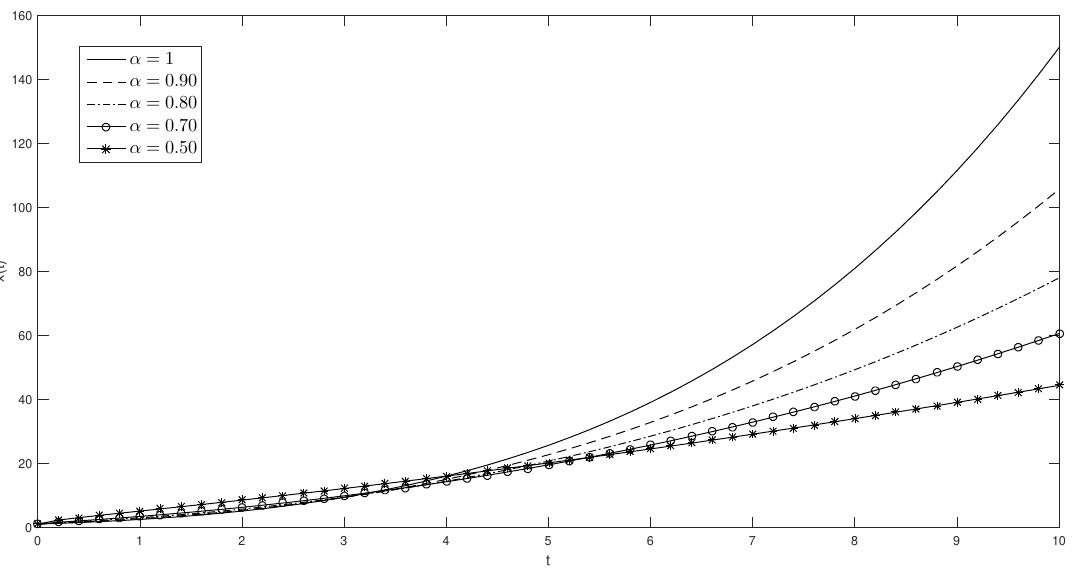
Figure 2. The physical behavior of x ( t ) with q = 0.5 and for different values of α